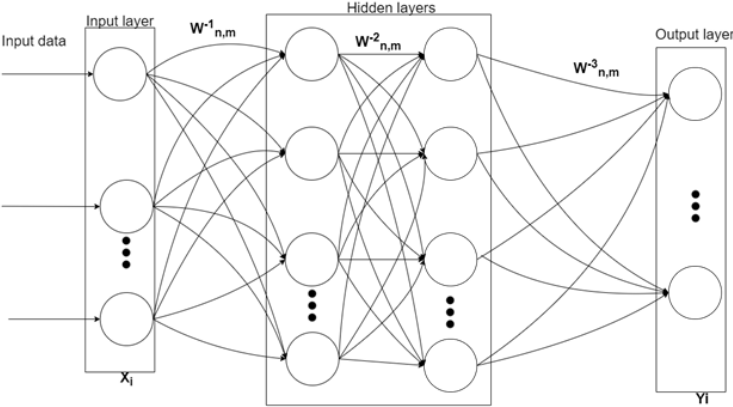
Figure 2. Self Organizimg Map Model.